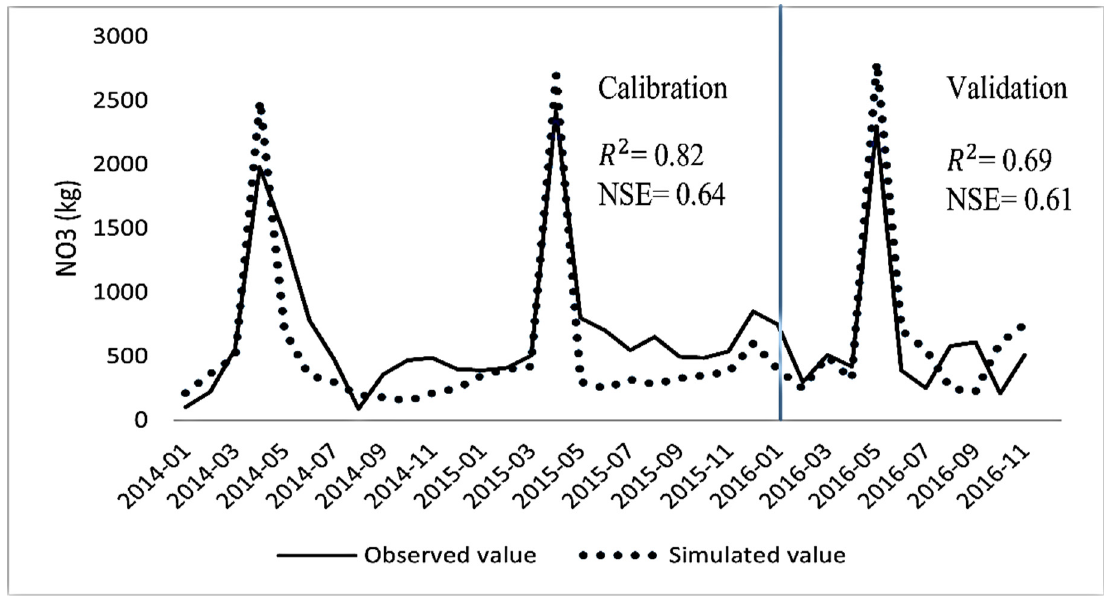
Figure 6. Monthly observed vs. simulated nitrate during model calibration and validation for 2014–2016 at the Roodak gauge.